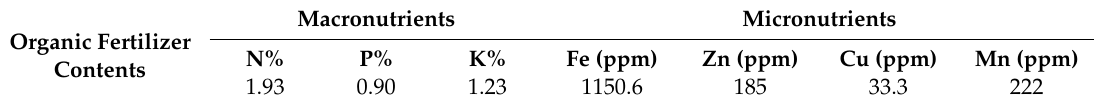
Table 2. Nutrient contents of poultry